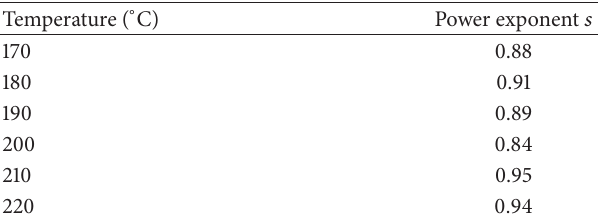
) for different tempera- 2